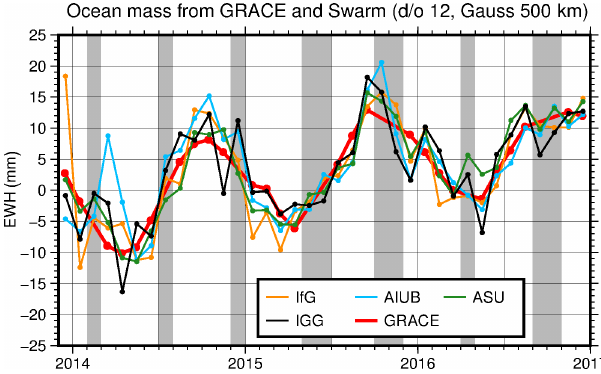
Figure 2. Ocean mass from ITSG-Grace2016 and Swarm. GRACE data gaps are highlighted in